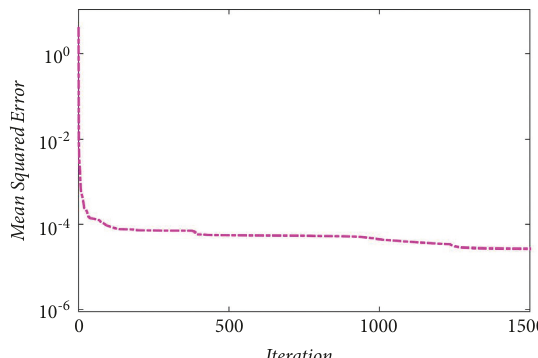
Figure 3: The training process of the ANFIS algorithm by